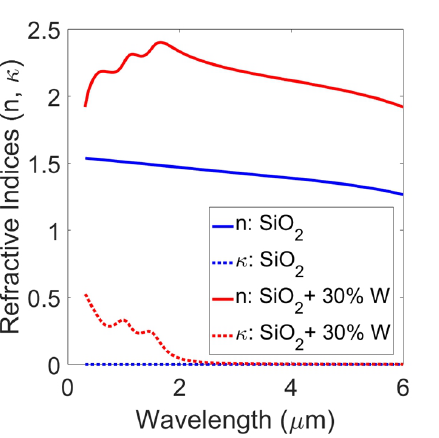
Figure 2. Real (n) and imaginary ( κ ) parts of refractive indices of pure SiO 2 and SiO 2 with 30% tungsten